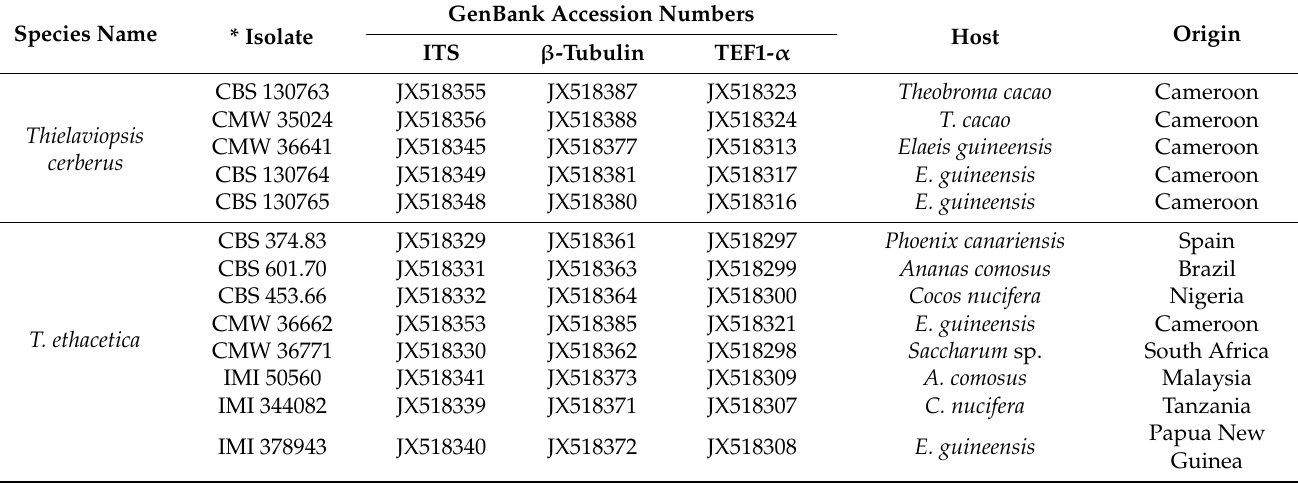
Figure 2. Pathogenicity test to fulfil Koch’s postulates for three T. punctulata isolates on date palm plants of the Khalas cultivar. The plants were inoculated with ( A ) double distilled water (control) and the T. punctulata isolates ( B ) TP1, ( C ) TP2, ( D ) and TP3, respectively. Typical symptoms as they appear on the heart ( upper panel ) and rachis ( lower panel ) are shown. Table 1. List of Thielaviopsis spp. for which isolates or sequences were included in this